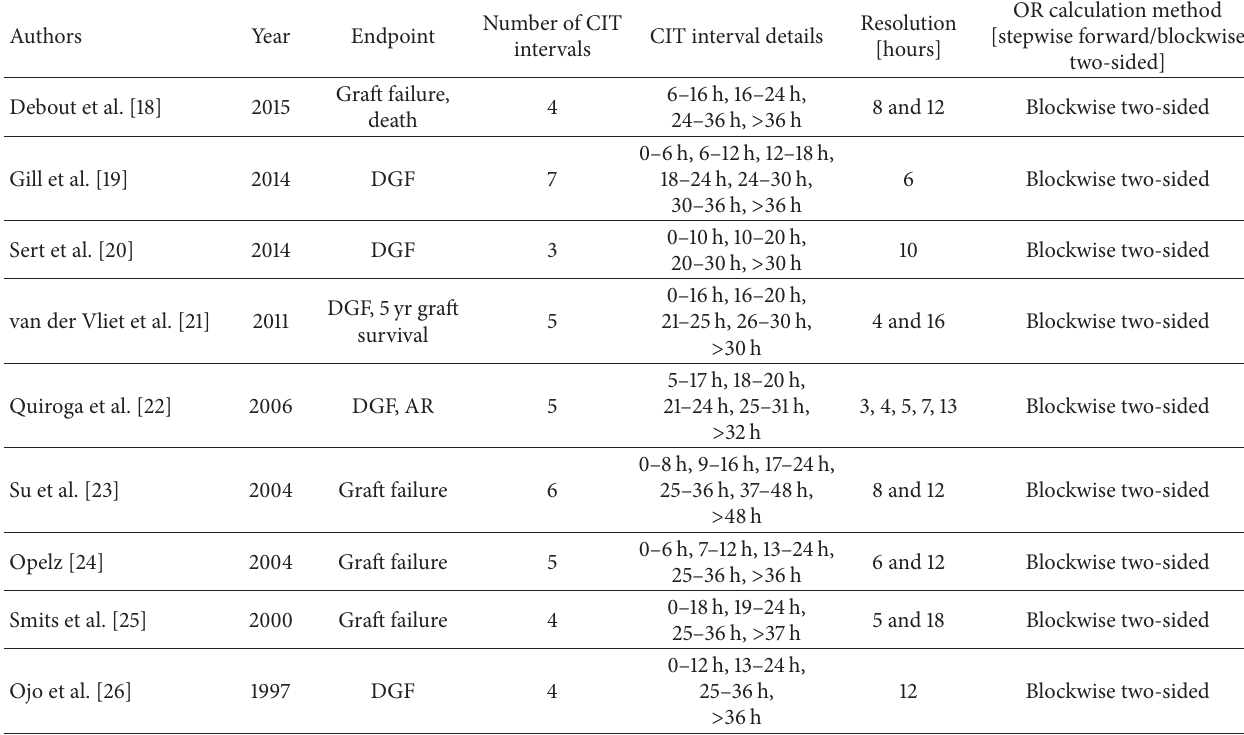
Table 8: Literature about CIT-impact on kidney transplantation